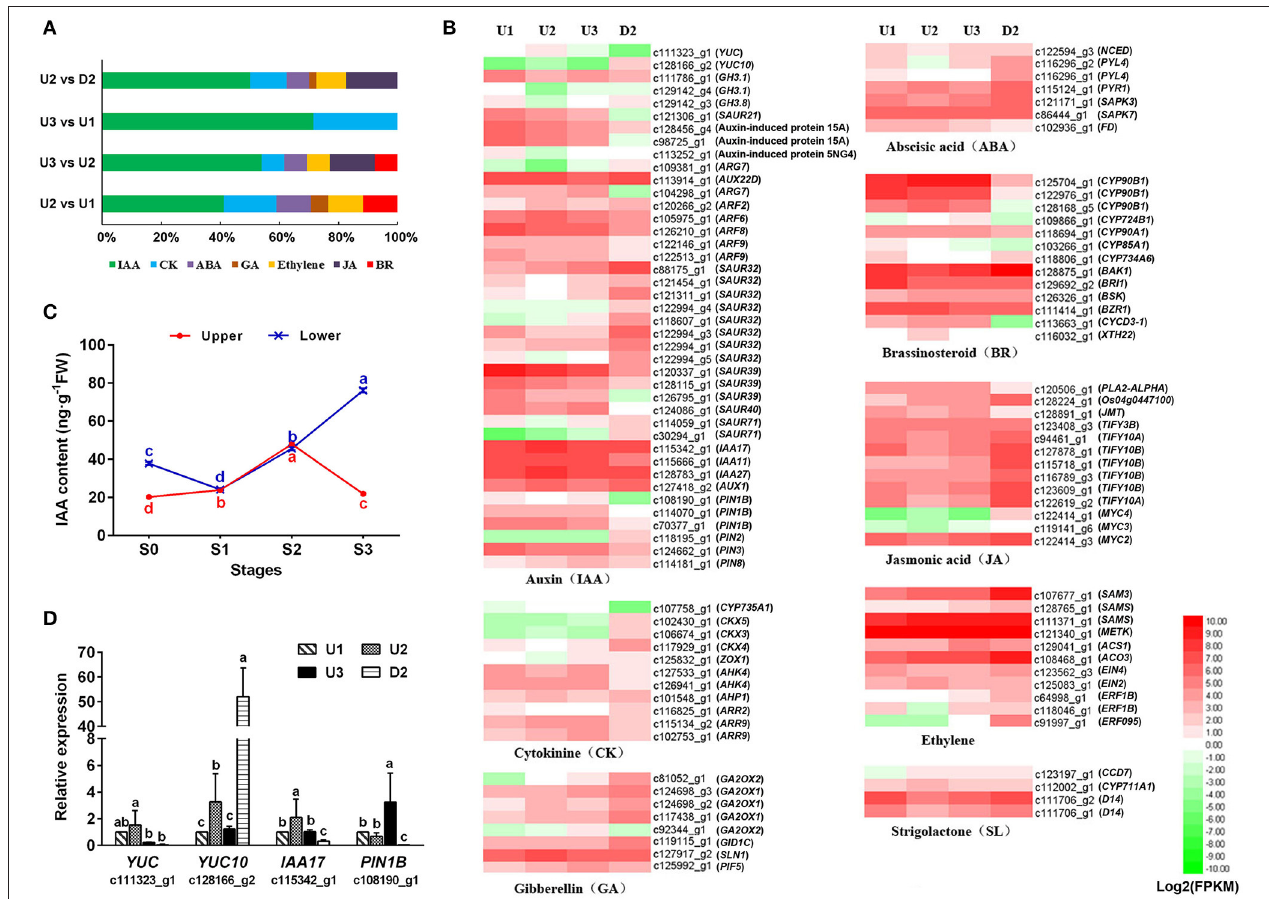
FIGURE 6 | Regulation patterns of plant hormones during the process of bulbil formation. (A) Distribution of DEGs related to plant hormone signal transduction compared pairwise among the four libraries. (B) Heatmap of the unigenes assigned to hormone synthesis and signal transduction pathways in the four transcriptomes: U1, U2, U3, and D2. The FPKM values of the unigenes were log 2 transformed, and a heatmap was generated using HemI 1.0. Red and green indicate up- and down-regulated transcripts, respectively. (C) IAA contents of the upper (red) and lower (blue) axils at different stages during bulbil formation. The representation of the x-axis, y-axis, significance tests and error bars are as described in Figure 5 . (D) qRT-PCR analysis of the expression profiles of four genes related to auxin signailing. The representation of the x-axis, y-axis, significance tests and error bars are as described in Figure 4C . Non-overlapping letters (a–d) in (C,D) indicate significant differences ( p < 0.05) for between the comparisons of different